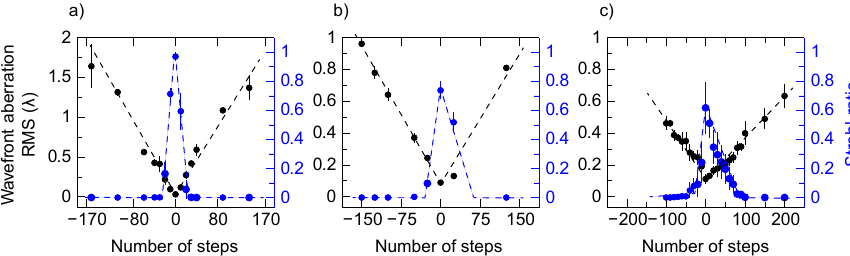
Figure 3. Evolution of the XUV wavefront root mean square (RMS) as a function of the focusing optics relative angle (number of steps) along the different axes: ( a ) rotation stage; ( b ) horizontal goniometer; and ( c ) vertical goniometer. The RMS is plotted in black dots in units of lambda for λ = 42 nm (left axis), with error bars coming from several single-shot measurements. The corresponding Strehl ratios are plotted in blue dots (right axis). The qualitative trends are plotted in dashed